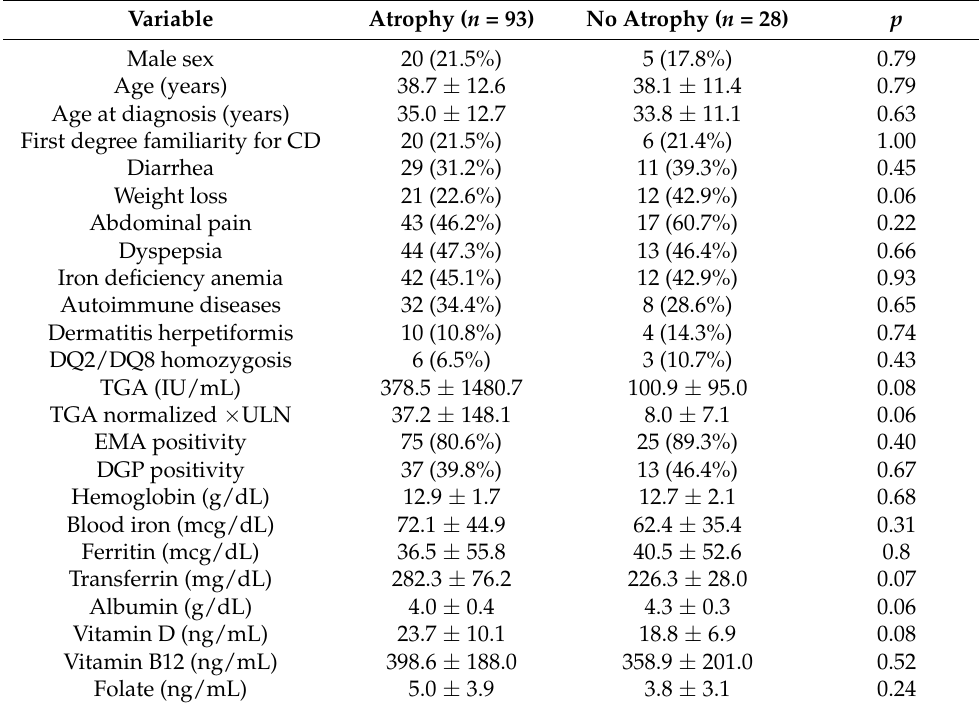
Table 2. Comparison of main characteristics of CD patients with and without villous atrophy.